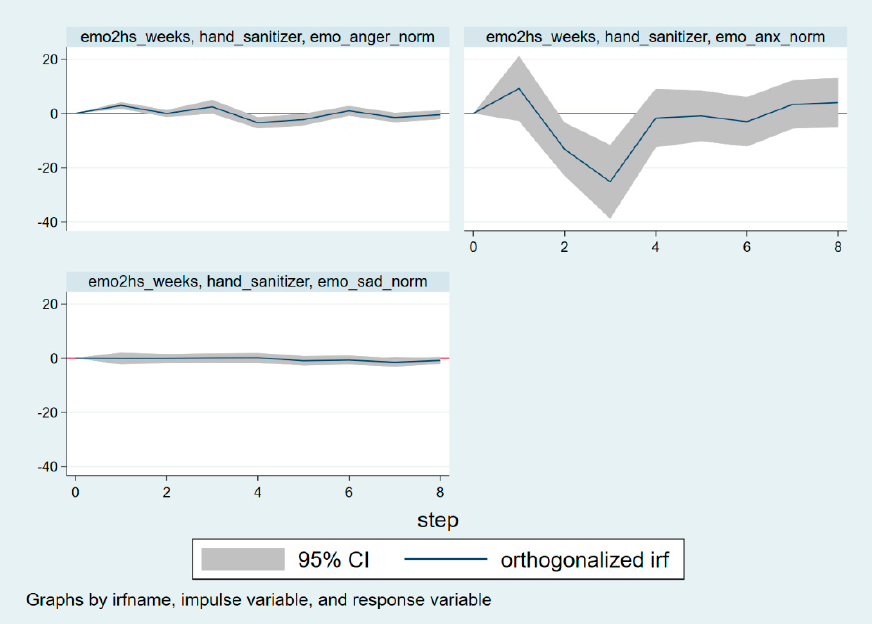
Figure 5. The responses of discrete emotions to one shock of preventive behavior.